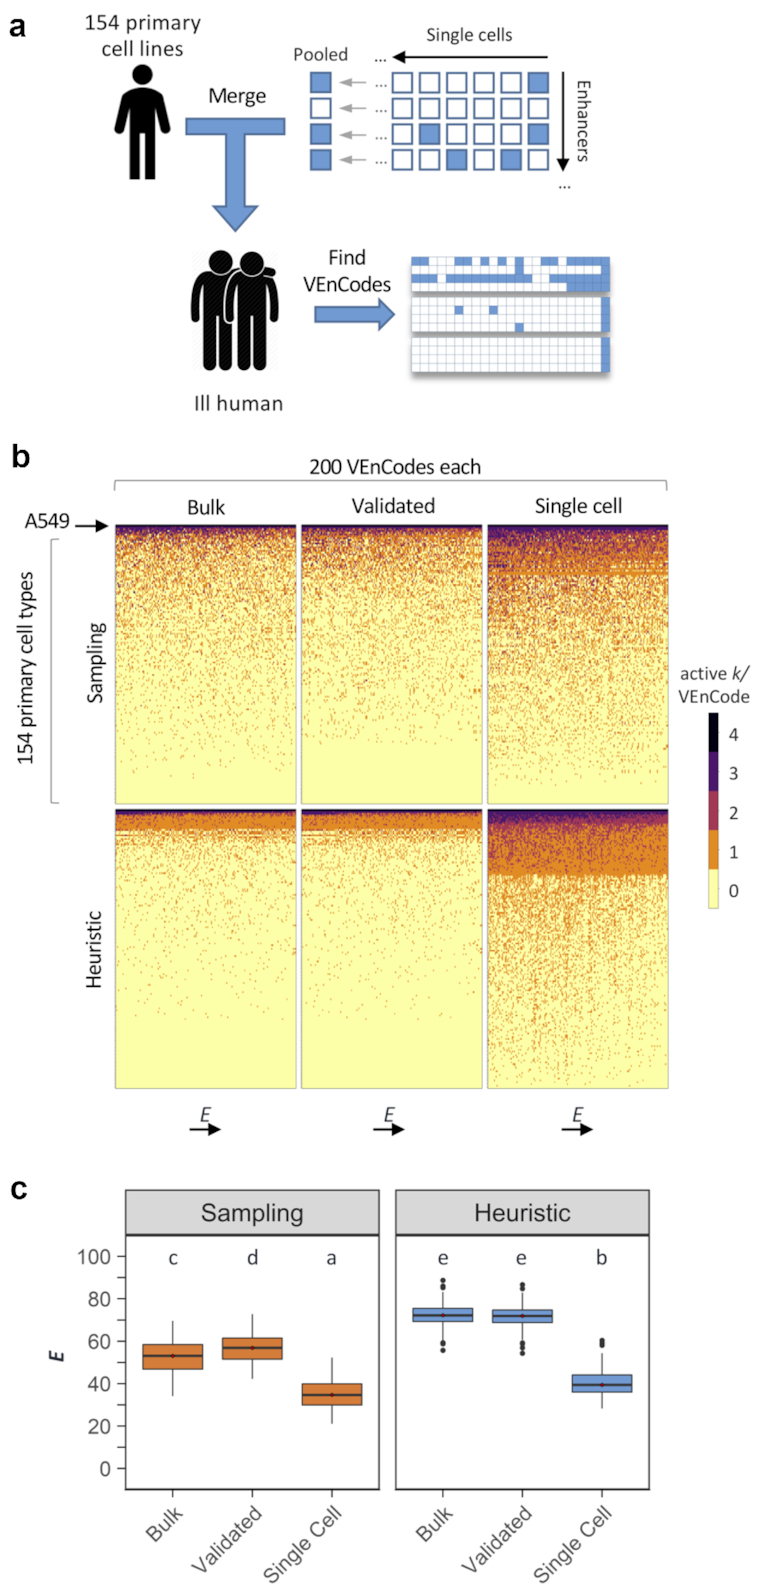
VEnCodes from single cell–derived RE usage data. (a) Strategy for integrating single cell–derived RE usage data into the VEnCode-generation pipeline. Single-cell data, such as enhancer usage patterns obtained from C1 CAGE-seq, are pooled and then integrated into the curated database of the bulk CAGE-seq enhancer panel. (b) Heat maps depicting the E quality of 200 k = 4 enhancer VEnCodes obtained by the sampling or heuristic method from single-cell (35 pooled “T0” cells from C1 CAGE-seq [43]), bulk CAGE-seq (FANTOM5), or bulk-validated CAGE-seq data (as described in Fig. 9) for A549 cells. Columns represent 200 VEnCodes ranked according to E value; rows represent cell types, ranked according to average ( [active k)]/VEnCode). (c) Box plots representing the quantification of the E value data reported in section b. Different letters represent conditions that are statistically significantly different (ANOVA performed with all 6 conditions, followed by Tukey HSD; P < 0.01).